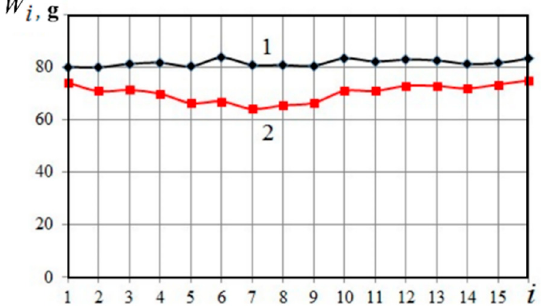
Figure 12. Masses of blocks composing LSM sample before (1) and after (2) test 3 with combustion. Burning time t 2 − t 1 = 3.46 – 1.15 = 2.31 s.